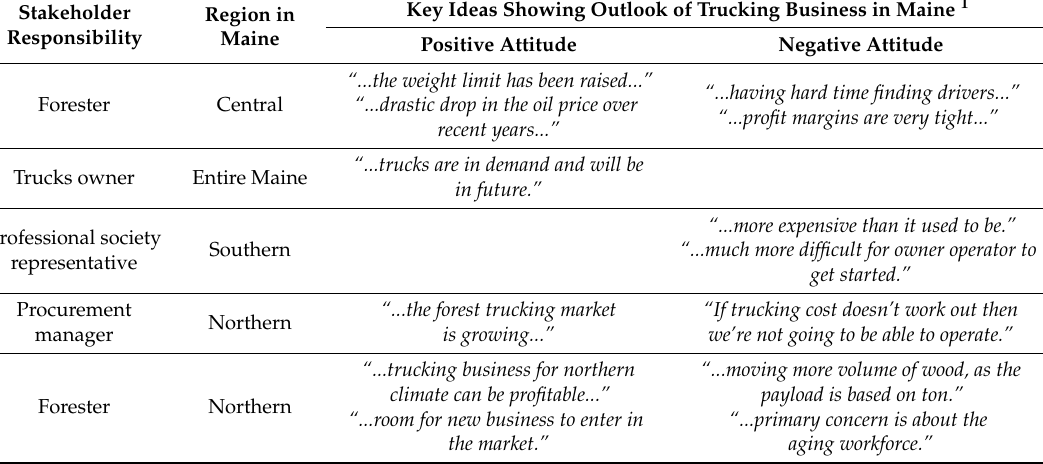
Table 2. Examples of the participants’ responses regarding the outlook of the forest trucking business in Maine. The blank cells indicate the absence of positive or negative attitudes of the